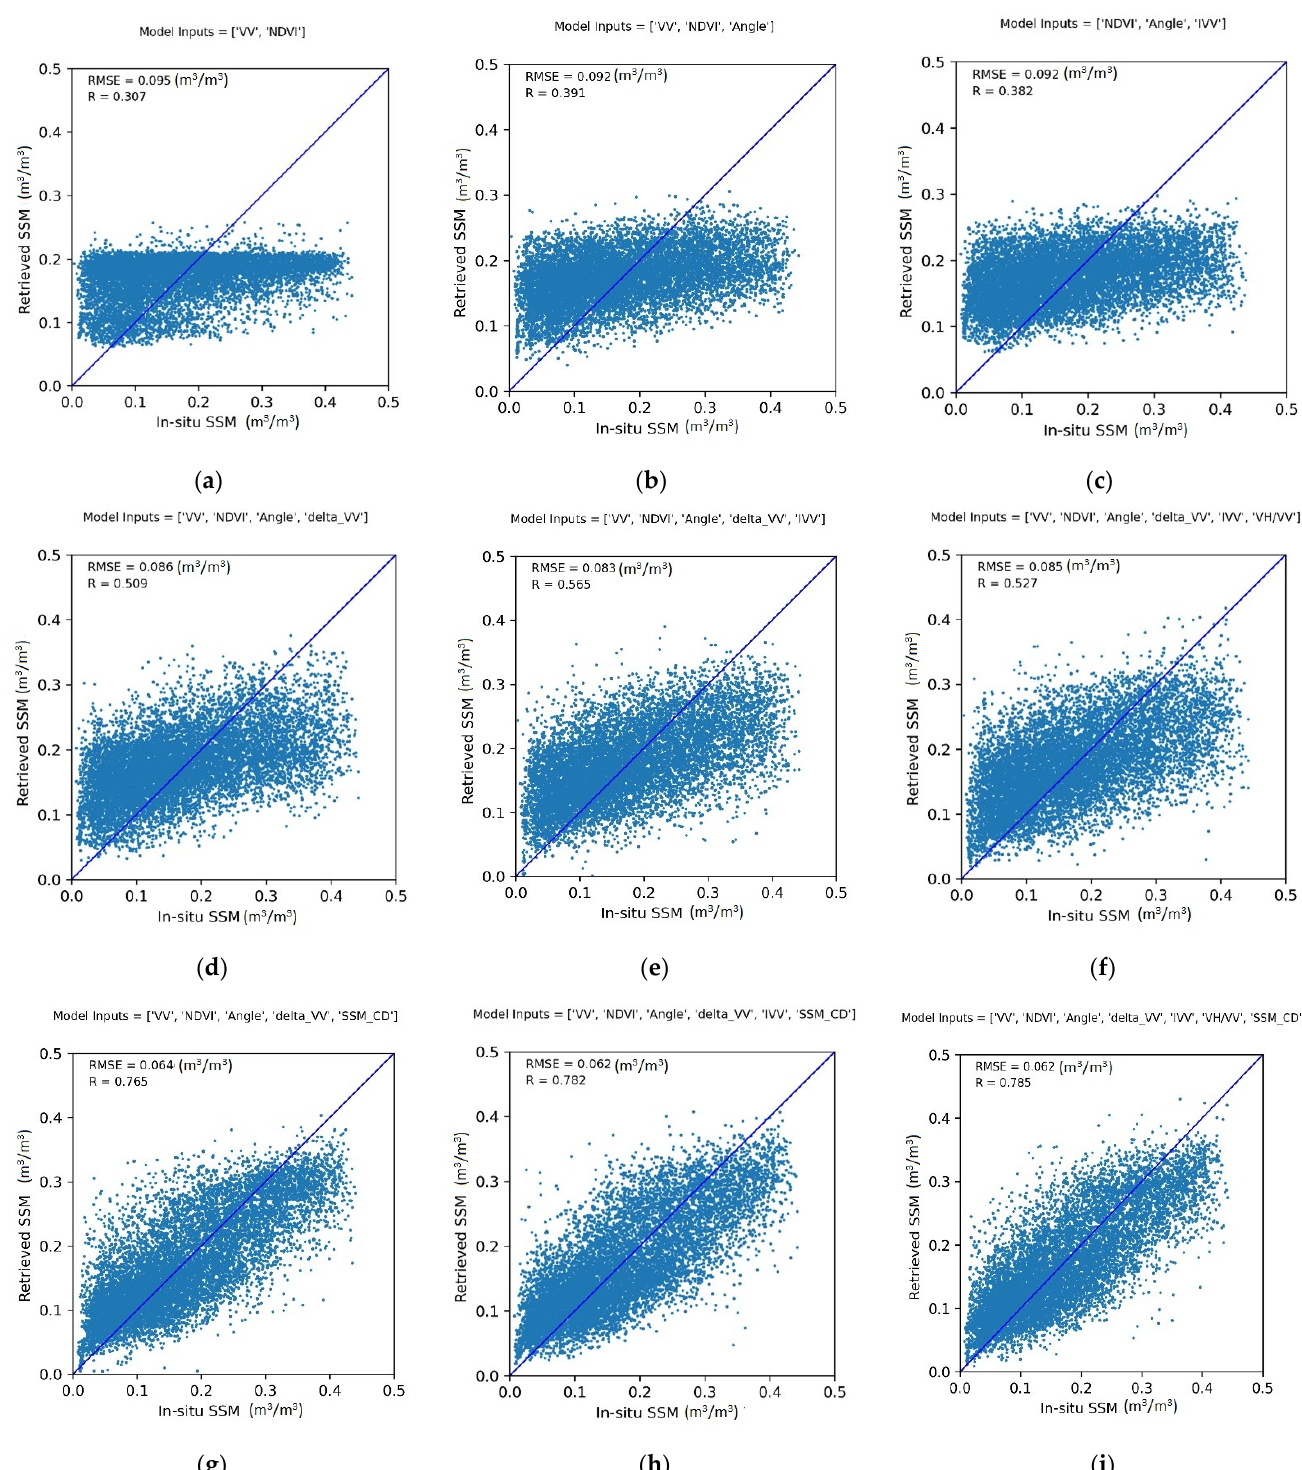
Figure 3. Scatterplots of the retrieved SSM as a function of in situ SSM measurements using the ANN approach using multiple combinations of features: ( a ) VV, NDVI , ( b ) VV, NDVI , the incidence angle, ( c ) NDVI , the incidence angle, I SSM , ( d ) VV, NDVI , the incidence angle, ∆ VV , ( e ) VV, NDVI , the incidence angle, ∆ VV , I SSM , ( f ) VV, NDVI, the incidence angle, ∆ VV , I SSM , VH/VV ratio, ( g ) VV, NDVI , the incidence angle, ∆ VV , SSM t , ( h ) VV, NDVI , the incidence angle, ∆ VV , I SSM , SSM t , ( i ) VV, NDVI , the incidence angle, ∆ VV , I SSM , VH/VV ratio, SSM t